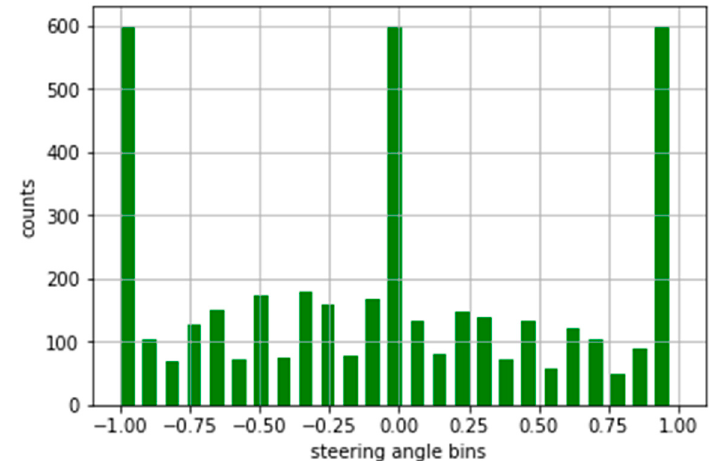
Figure 10. Normalized form of the dataset.